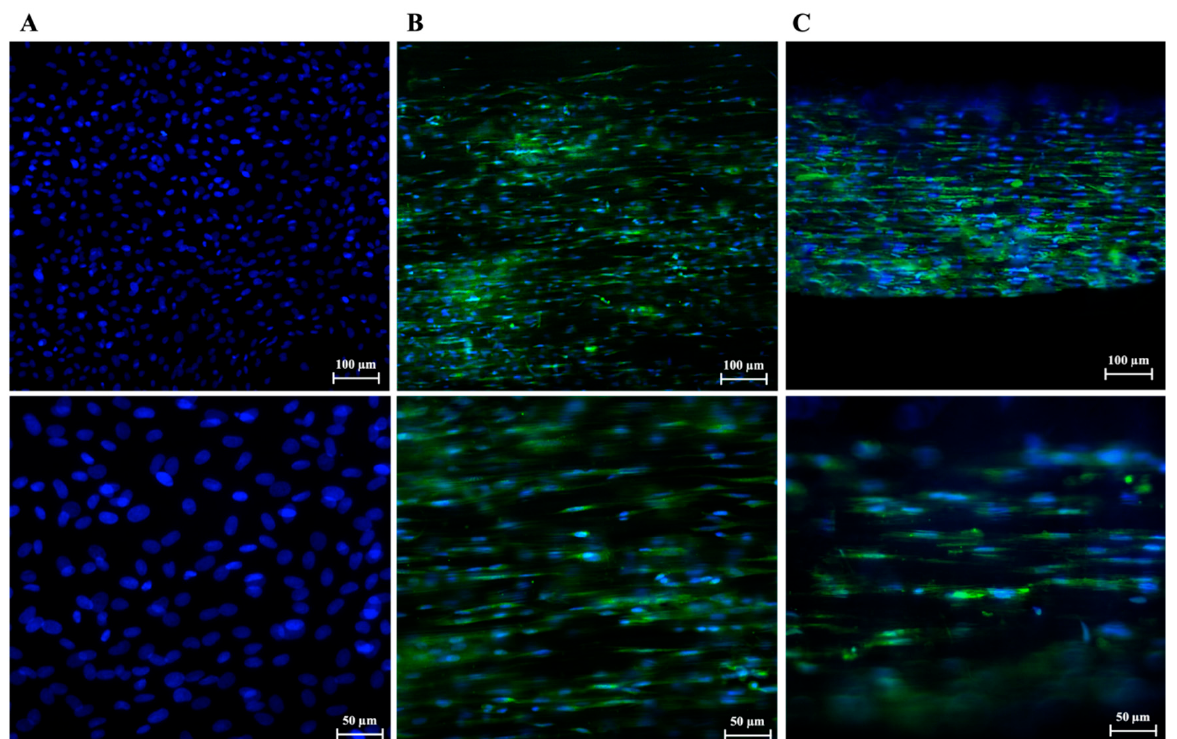
Figure 6. IF images of TNMD protein expression (green fluorescence) in AECs seeded on ( A ) Petri dishes used as CTR, ( B ) PLGA fleeces and ( C ) 3D scaffolds; DAPI (blue fluorescence)-counterstained nuclei.